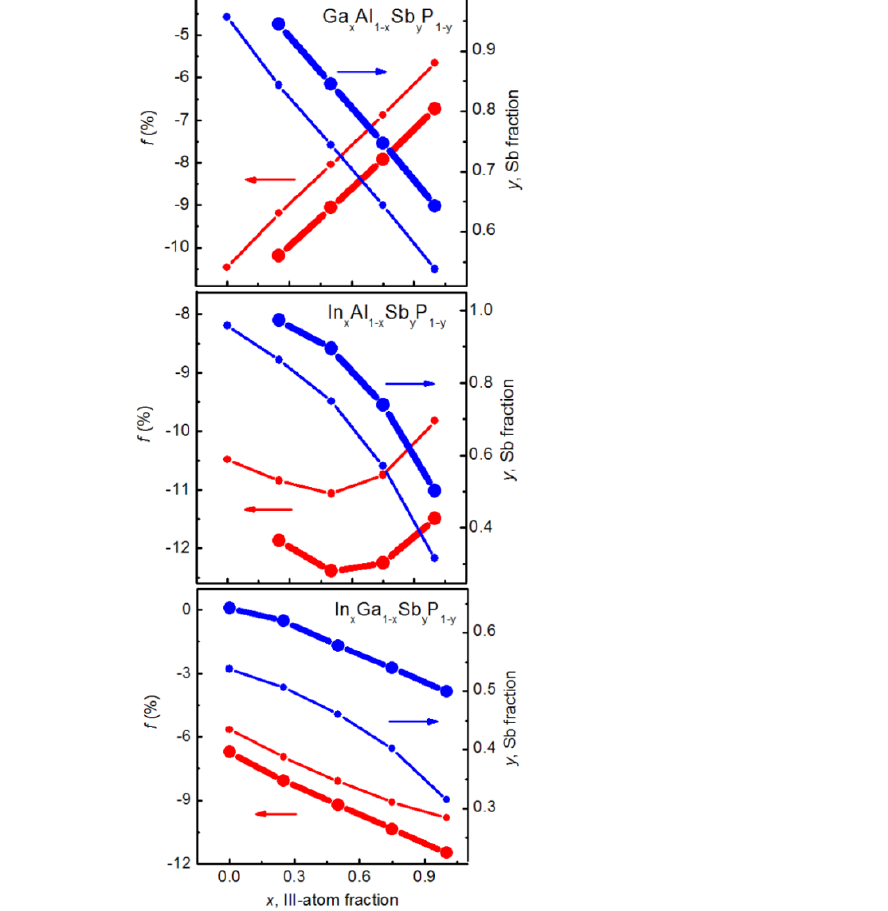
Figure 13. Sb fraction ( y ) as a function of group III element content ( x ) for the SAQD quaternary alloy (blue dots) calculated for the E loc value equal to 1.35 (thin dot-lines) and 1.50 eV (thick dot-lines). Red dot-lines give the SAQD/matrix lattice constant mismatch f as a function of x with a corresponding y fraction.